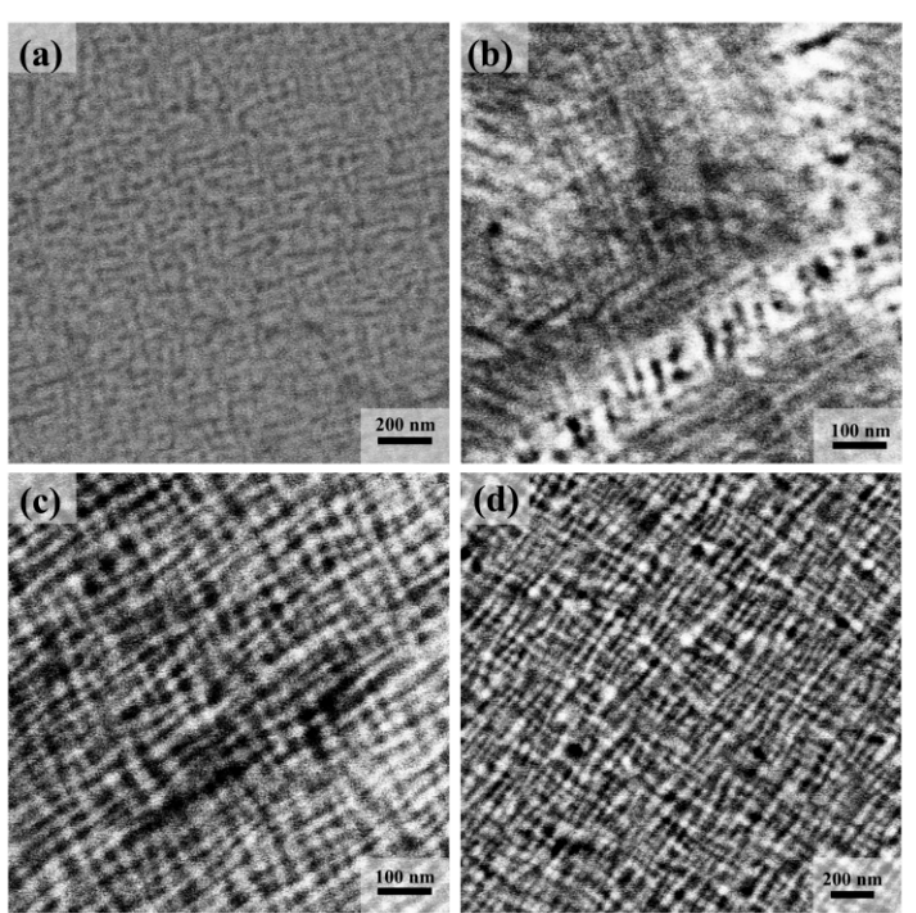
Figure 2. SEM back-scattered images of RHEAs at 873 K-aged state. ( a – d ): S0, S1, S2 and S3, respec- tively.